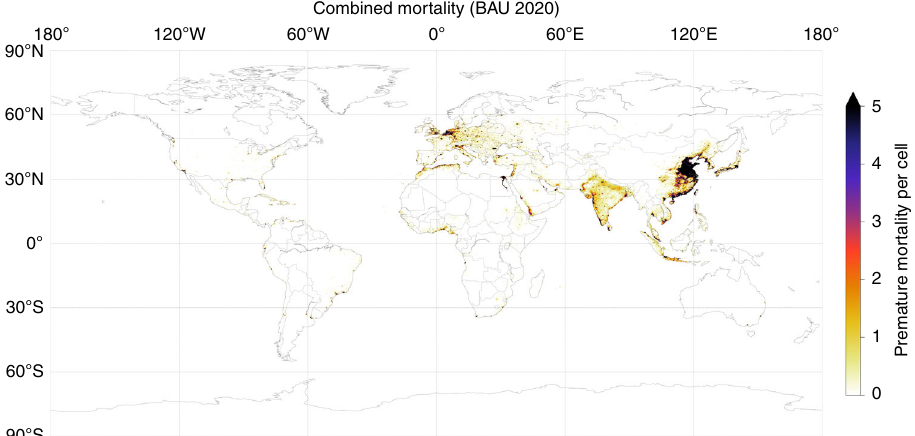
Fig. 3 Mortality due to ship emissions under a business-as-usual case. Map of combined mortality (from cardiovascular disease and lung cancer) due to PM 2.5 emissions from ships under a business-as-usual case for 2020. The in-grid-cell minimum and maximum mortality estimates are 0 and 2550, respectively